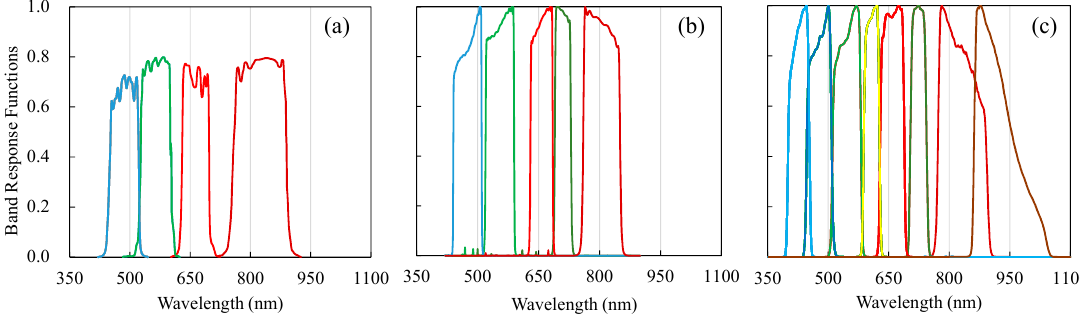
Figure 1. Band response functions for: FORMOSAT-2 ( a ); RapidEye ( b ); and WorldView-2 ( c ) satellite sensors used in this study.